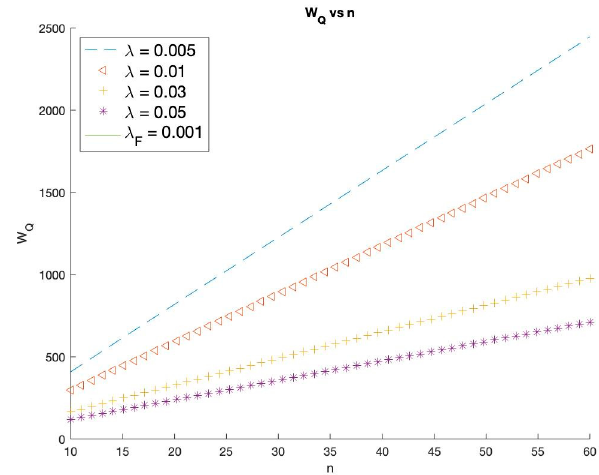
Figure 7. Average amount of time in queue ( W Q ) vs number of slots ( n ).